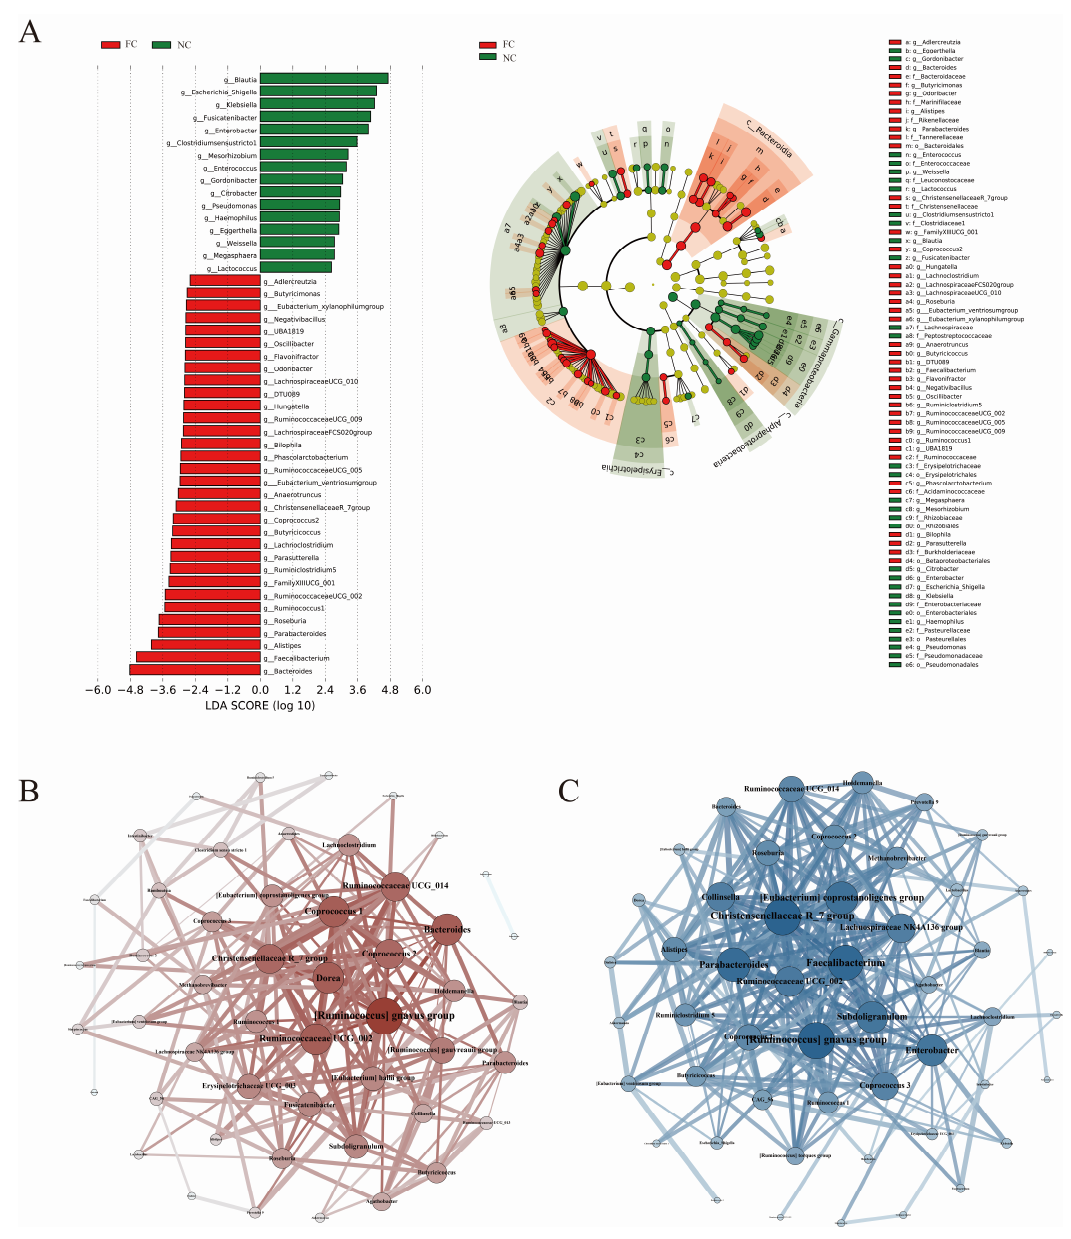
Figure 2. ( A ) LEfSe analysis for key genera selection. LDA score plot shows the differential genera. Higher LDA scores represent greater contribution of bacterial genera to the differences. Cladogram demonstrates differences at different levels. ( B , C ) Gut microbial network of the FC group and the NC group. The darker the dot’s color and larger the its size, the more related genera this genus has. A thicker line represents a stronger